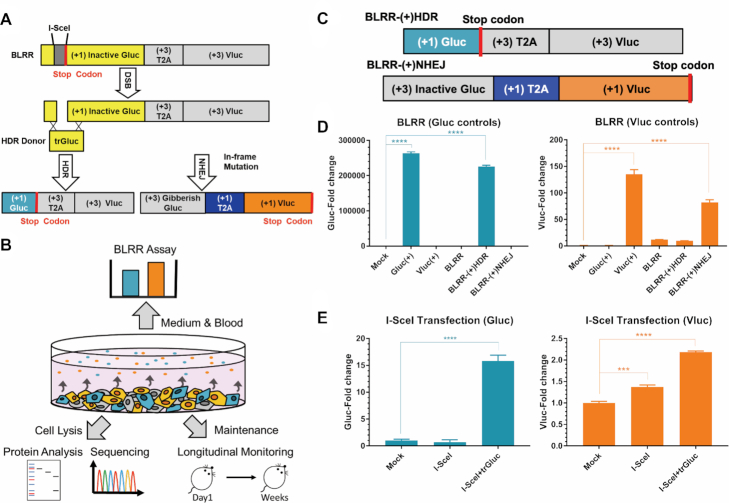
The bioluminescence DNA repair reporter (BLRR) can detect HDR and NHEJ events. (A) Schematic diagram and mechanism of BLRR assay detection of HDR and NHEJ repair pathways. (+) indicates the position of the reading frames with (+1) denoting the in-frame reading frame. An I-SceI meganuclease target site was inserted into the Gluc sequence followed by 2 bp frame-shifted T2A and Vluc sequences. Following DSB, NHEJ repair will generate frameshift mutations in inactive Gluc, resulting in Gibberish Gluc, and one of three frameshifts will create an in-frame T2A-Vluc sequence. When the trGluc donor template is present, HDR occurs and repairs the mutated Gluc sequence, yielding wild-type Gluc. (B) The BLRR system enables non-disruptive analysis of DSB repair outcomes using a small volume of medium or biofluid without disrupting cells. Cells and organisms can be further longitudinally monitored and/or collected for subsequent molecular analysis such as NGS and proteomics. (C) Schematic diagram of BLRR control plasmids. BLRR-(+)HDR serves as an HDR positive control by replacing the inactive Gluc sequence in BLRR with the wild-type Gluc sequence. BLRR-(+)NHEJ serves as an NHEJ positive control by replacing the I-SceI target sequence in BLRR with a +1 bp frame-shifted I-SceI target sequence to generate (+3) Gibberish Gluc, thus creating in-frame T2A and Vluc. (D) BLRR emits Gluc and Vluc signals without signal crosstalk. 293T cells transfected with BLRR display undetectable Gluc signals and barely detectable Vluc signals. As positive controls for BLRR, 293T cells were transfected with either BLRR-(+)HDR or BLRR-(+)NHEJ, and cells exhibited robust Gluc or Vluc activity, respectively, without signal crosstalk. As positive controls for bioluminescent reporters, Gluc(+) or Vluc(+) was transfected into 293T cells to express wild-type Gluc or Vluc, respectively. A representative experiment composed of three independent experiments with three biological replicates is shown. BLRR signals were normalised against cell viability and results are shown as the fold change relative to the mock control (mean ± SEM of three biological replicates). (E) BLRR demonstrates I-SceI-induced DSB repair. The Vluc signal is increased in the presence of I-SceI, whereas the Gluc signal is only increased when trGluc is co-expressed. A representative experiment composed of three independent experiments with three biological replicates is shown. BLRR signals were normalised against cell viability and results are presented as the fold change relative to mock the control (mean ± SEM of three biological replicates). Significance was calculated using one-way ANOVA compared to the mock control, followed by Tukey post-hoc test (*P < 0.05, **P < 0.01, ***P < 0.001, ****P < 0.0001).